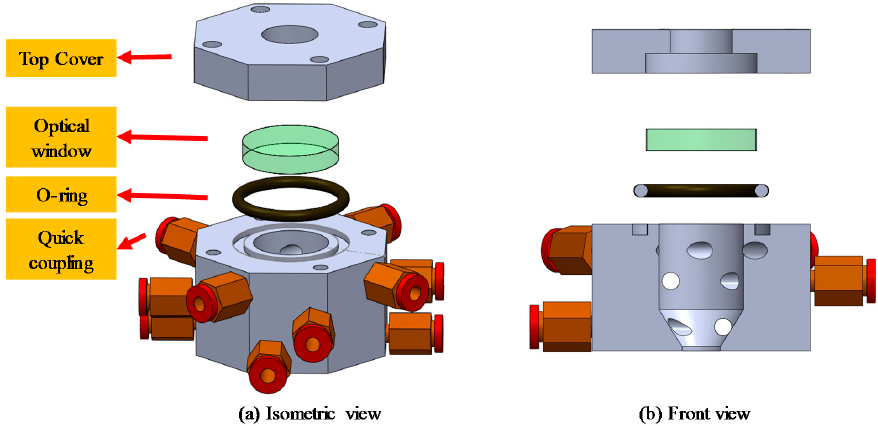
Figure 1. Assembly of swirling gas jet nozzle unit for field laser machining. ( a ) Isometric view; ( b ) front view.